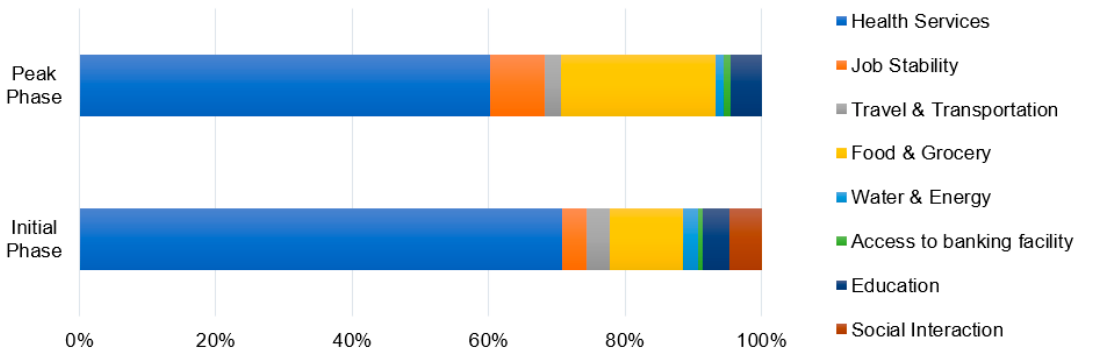
Figure 7. Topmost concerns identified by the survey respondents during COVID-19 lockdown.